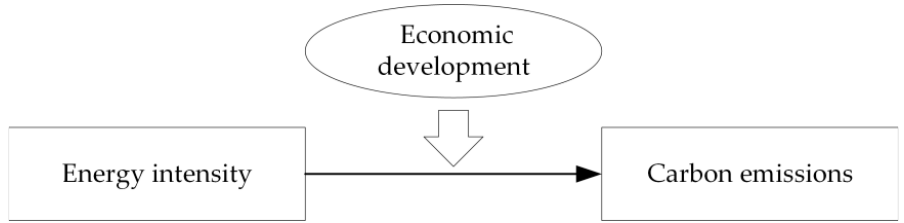
Note: *, **, and *** indicate that the coefficients are statistically significant at the 10, 5, and 1% levels, respectively.